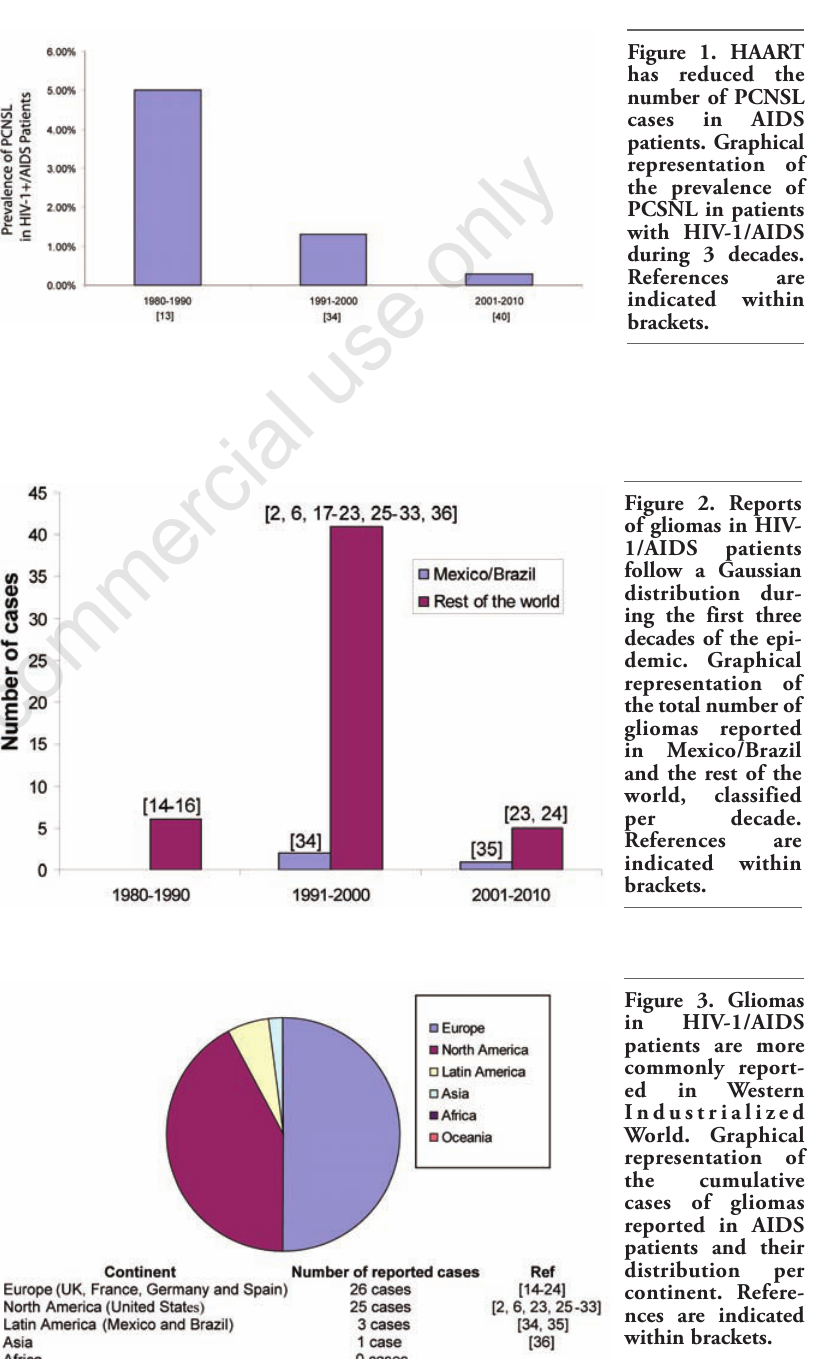
Figure 3. Gliomas in HIV-1/AIDS patients are more commonly report- ed in Western In d u s t r i a l i z e d World. Graphical representation of the cumulative cases of gliomas reported in AIDS patients and their distribution per continent. Refere - nces are indicated within